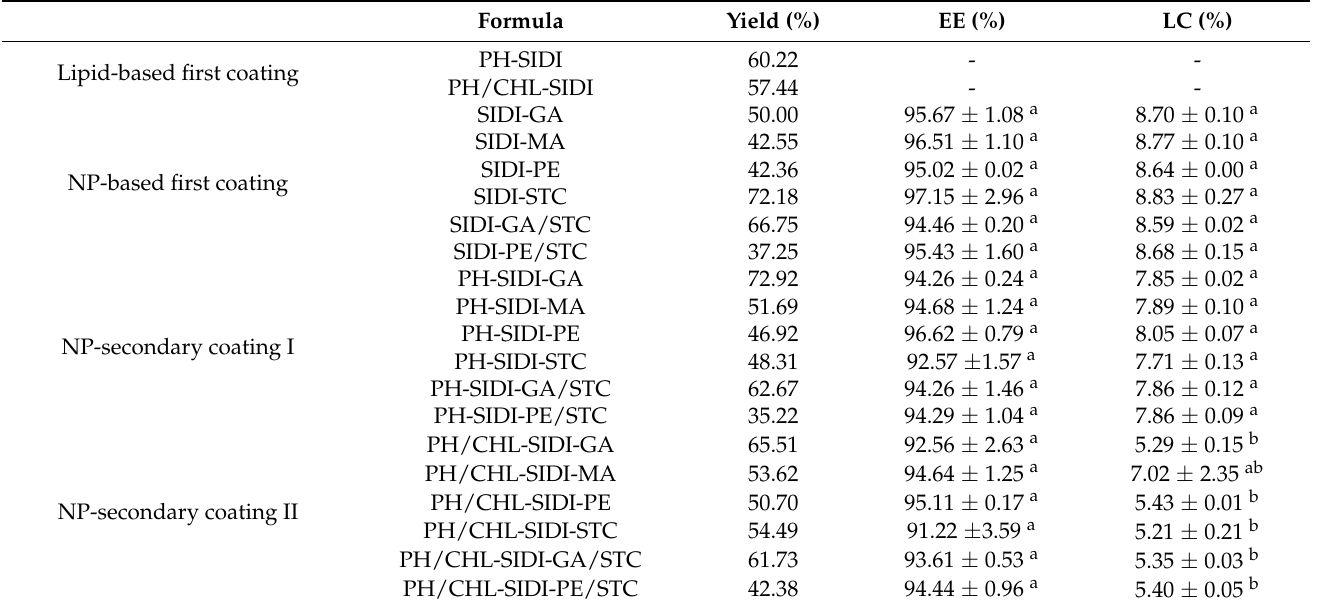
Table 3. Product yield, encapsulation efficiency, and loading capacity of formulated samples in